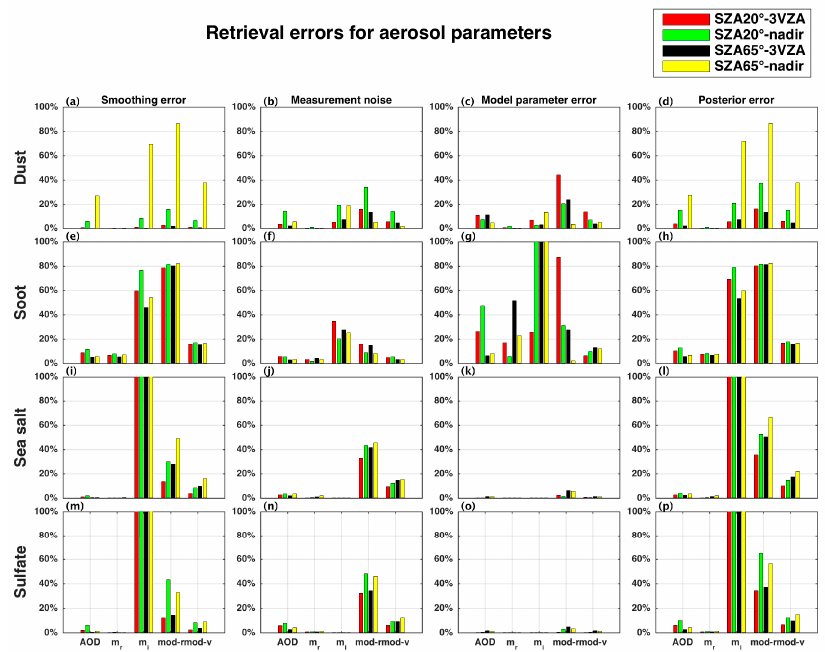
Figure 5. Different error estimates (1 σ ) of aerosol parameters at different solar zenith angles in nadir and multi-angle mode. Others are the same as Figure 4. and multi-angle mode. Others are the same as Figure